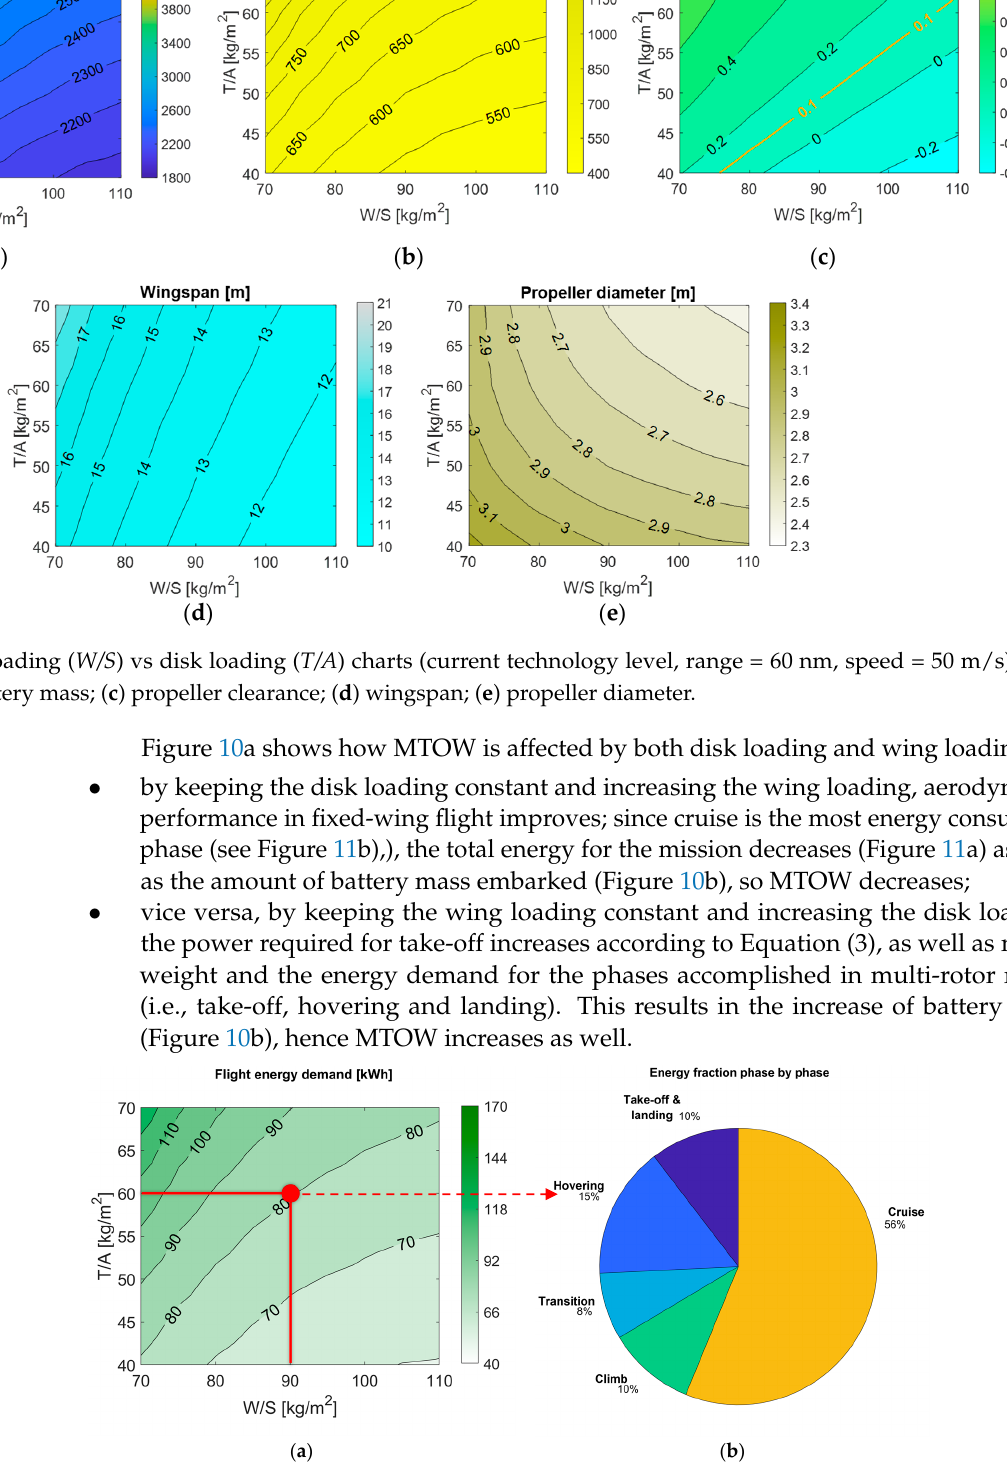
Figure 11. Energy demand to fly the design mission (range = 60 nm, speed = 50 m/s): ( a ) sensitivity analysis to wing loading and disk loading; ( b ) energy requirement phase by phase, for design point W/S = 90 kg/m 2 and T/A = 60 kg/m 2.